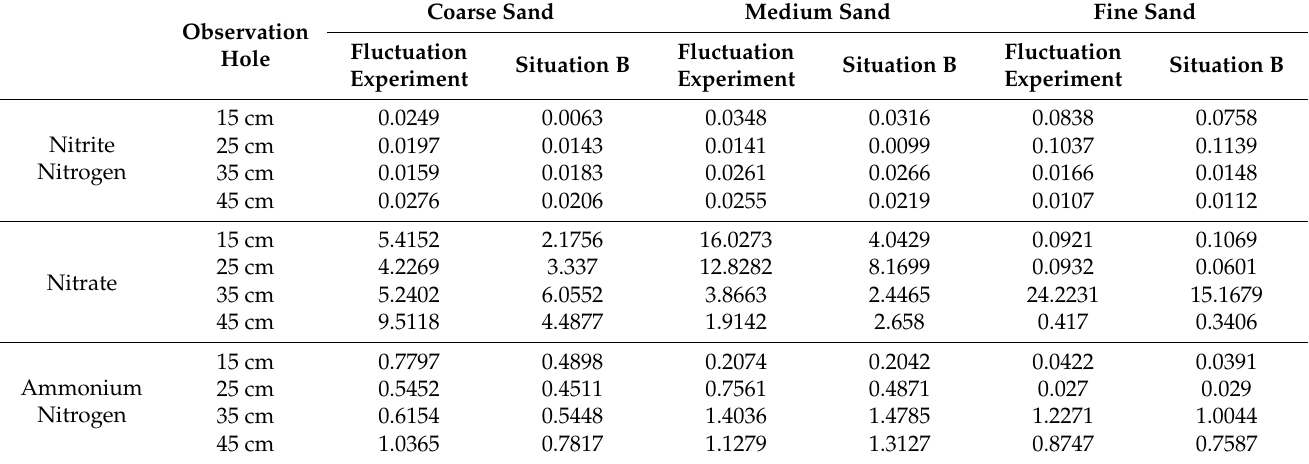
Figure 13. The measured results of medium sand and the dynamic process of nitrogen in situation B (( a ) nitrate nitrogen; ( b ) nitrite nitrogen; ( c ) ammonium nitrogen). The comparison of the standard deviation of the nitrogen concentration obtained by the three media simulations is shown in Table 7. Table 7. Scenario B model standard deviation